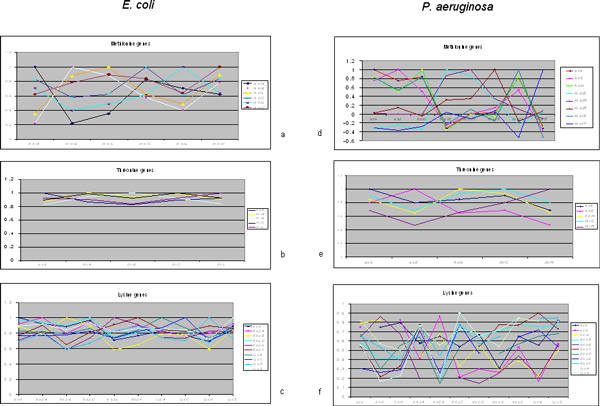
Microarray data analysis. Comparison between the expression pattern of each met, lys, thr gene of E. coli (a, b, c) and P. aeruginosa (d, e, f).